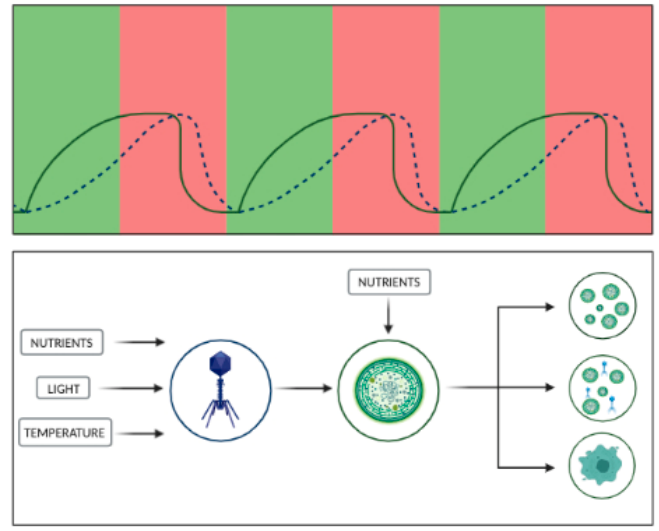
Figure 2. Cyanophages and nutrient cycling in cyanobacteria. The viral infection of algae can result in multiple cell fates. According to the diagram, part of the population would be metabolically active while still being infected, serving as viral particle releasing machines; the second part of the population would be lysed upon the infection, releasing organic matter; lastly, a part of the population would be resistant to the infection, thus serving as an inoculum for future populations. On top of this, the cycle of cyanobacterial population growth is also closely linked to the level of available nutrients. This relationship (similar to a typical predator–prey curve) can thus be described as follows, high-nutrient phases are characterized by progressive growth of algal populations (solid line), which in turn leads to the progressive growth of viruses (dotted line). Upon reaching a certain growth point, the cyanobacterial population experiences nutrient limitation, as late phases of algal blooms have been demonstrated to have low levels of available P and N. Under such conditions, phages can utilize cellular host machinery in order to maintain the phage population, leading to (1) release of viral particles for maintenance of the phage population, (2) release of organic matter for further decomposition by microbes, and (3) development of a resistant cyanobacterial population for the beginning of a new cycle.